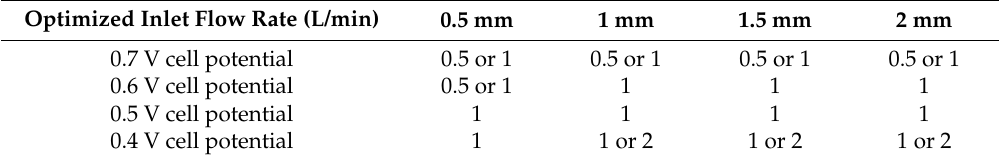
Table 2. Optimal inlet flow rate for four single serpentine flow fields with different land widths at different cell potentials when the pumping power is considered.